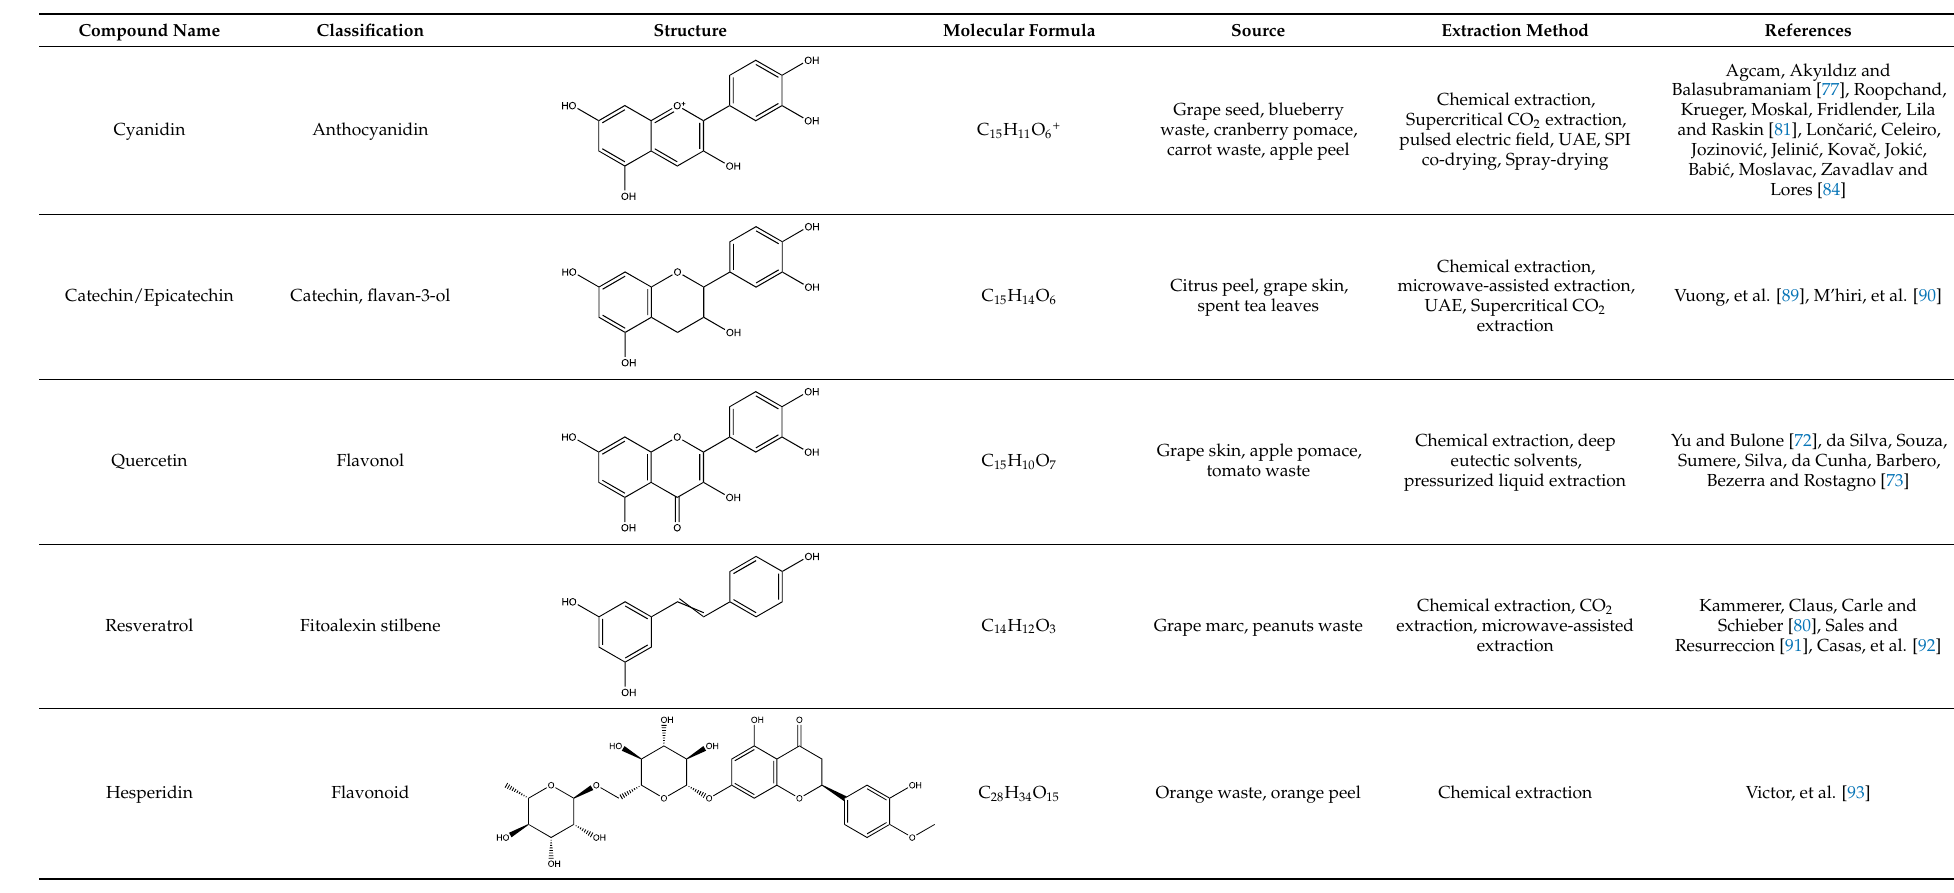
Table 1. Important polyphenols isolated from common fruit and vegetable waste.